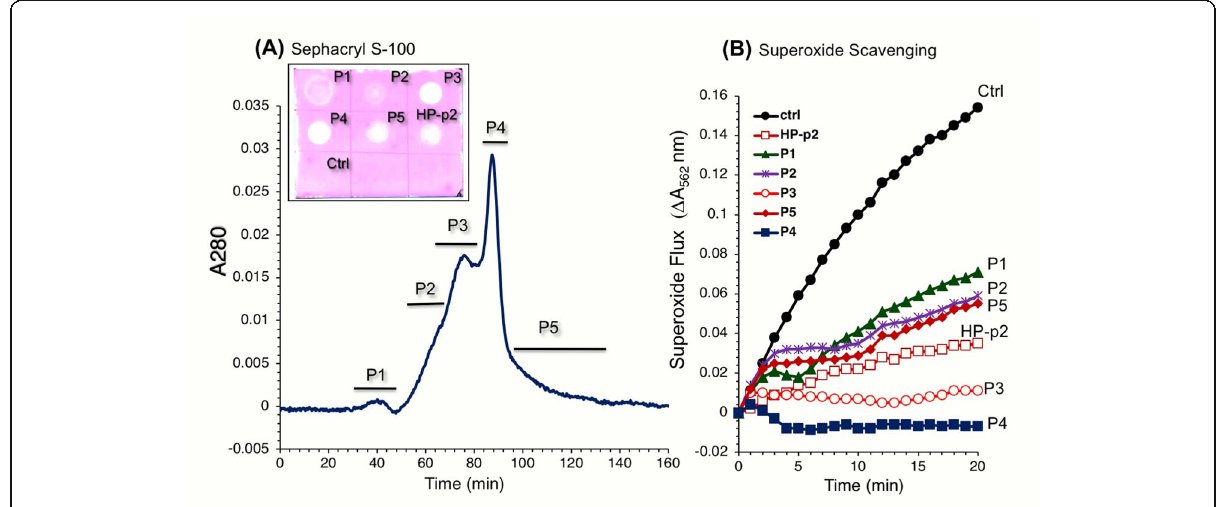
Fig. 3 Size-exclusion chromatography of the peptic hydrolysate HP-p2. Peptides elution from Sephacryl S-100 column was monitored at 280 nm ( a ). Superoxide-scavenging activity of the separated peptide fractions, labeled P1-P5, was kinetically measured in xanthine/XOD/NBT reduction assay performed at 37 °C for 20 min ( b ). Ctrl, reaction in the absence of protein. The ordinate represents the absorbance change versus time. Symbols are: Ctrl (solid circle), HP-p2 (open square), P1 (solid triangle), P2 (asterisk), P3 (open circle), P4 (solid square), P5 (solid